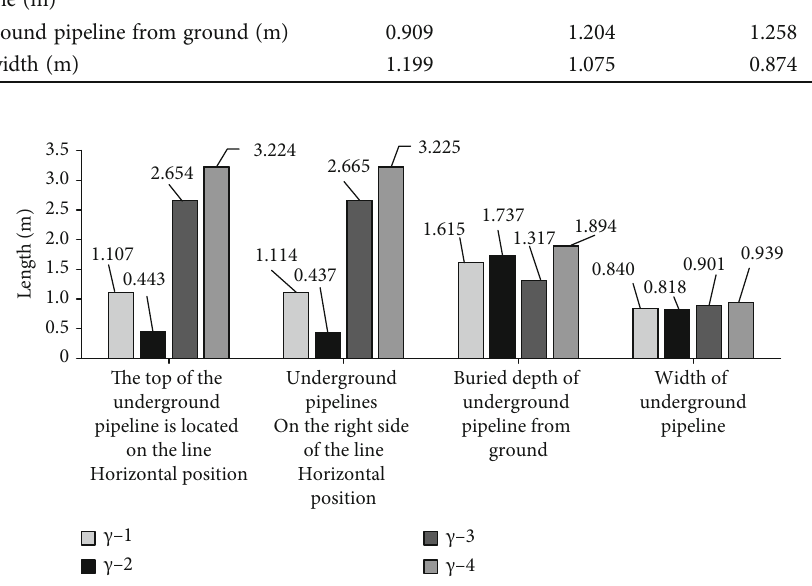
Figure 8: Location of underground pipelines in section γ